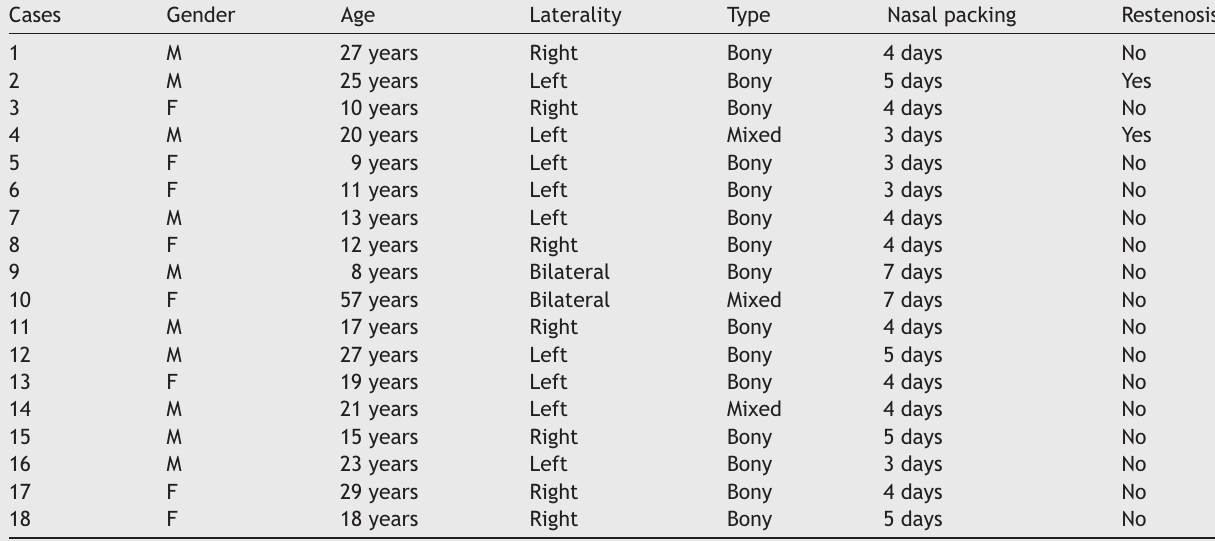
Table 1 Clinical characteristics of patients. Cases